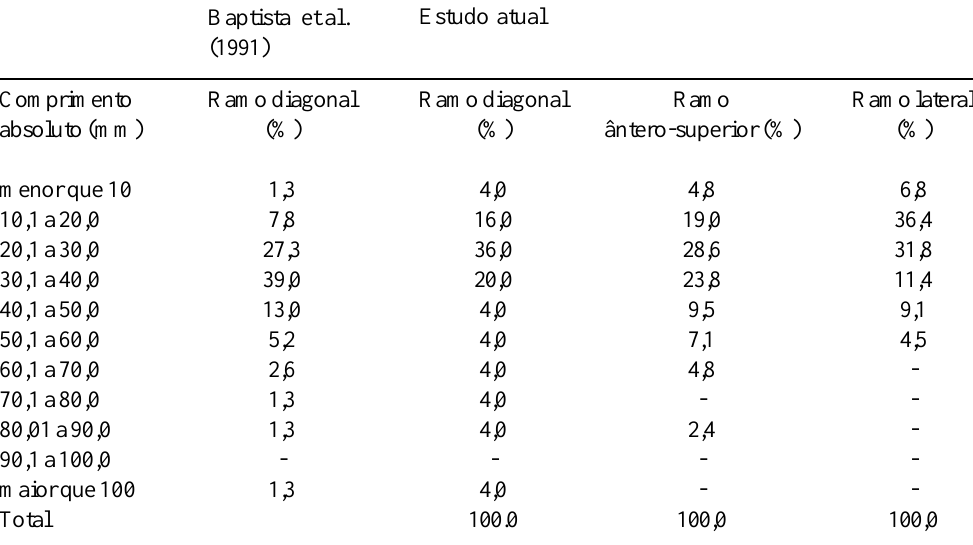
Tabela 6. Variação do comprimento no epicárdio do ventrículo esquerdo dos ramos diagonal,